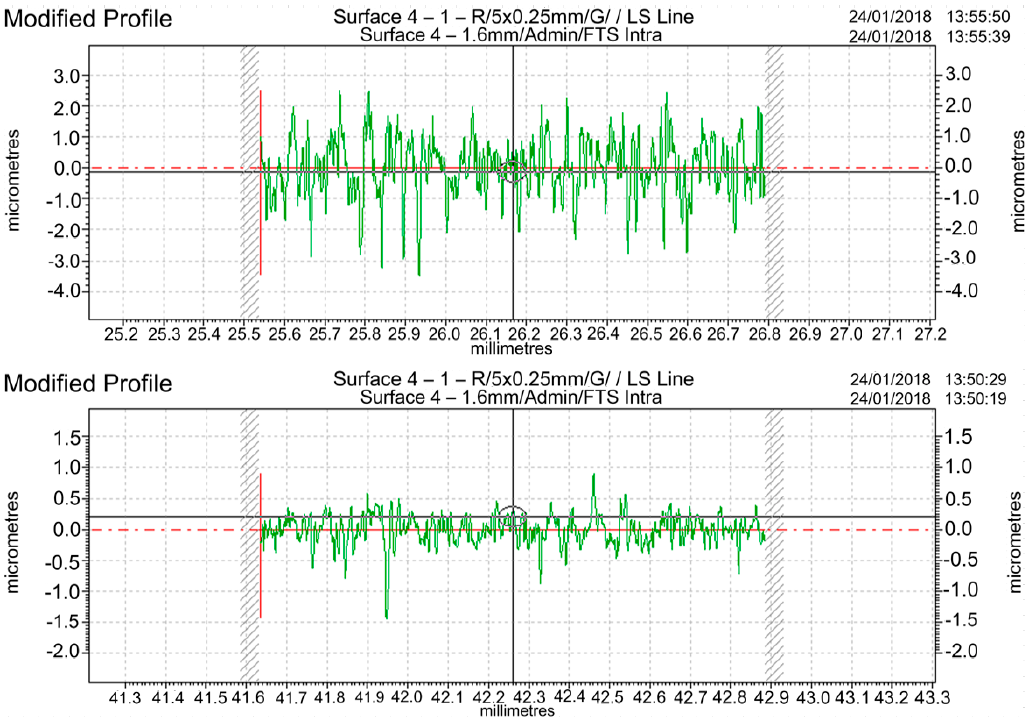
Figure 8. The contrast between the pre-grinding contour ( top ) and the post-grinding contour ( bottom ).